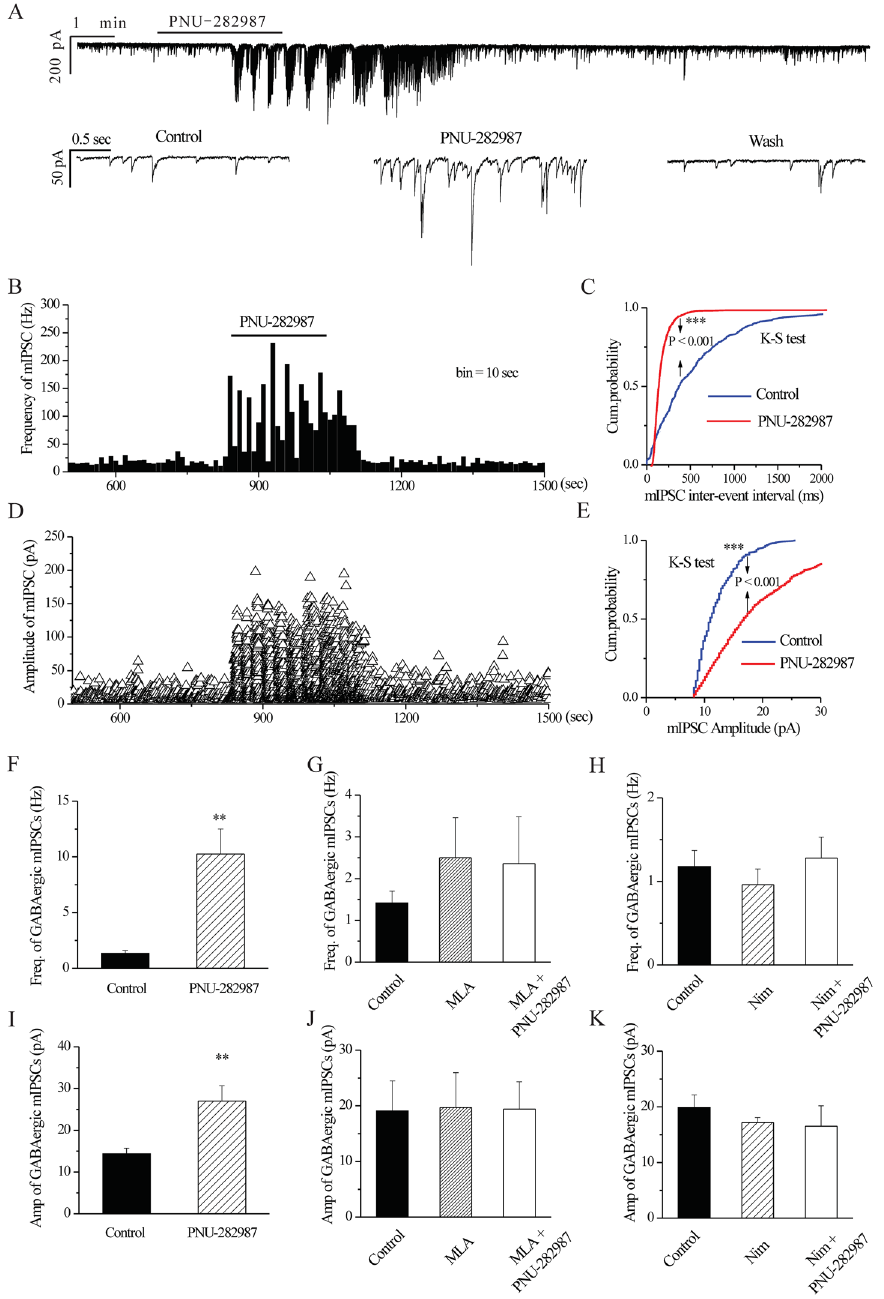
Figure 8. The effects of PNU-282987 on the frequency and amplitude of mIPSCs in glaucomatous RGCs are prevented by MLA or nimodipine. ( A ) Continuous trace of a representative experiment showing mIPSCs at baseline, during PNU-282987 application (10 μ M), and during recovery. The trace is shown at a magnified scale in the lower panel in A. Vertical bar, 200 pA (top) or 50 pA (bottom); horizontal bar, 1 min (top) or 0.5 s (bottom). ( B,D ) Frequency (10 s bin) and amplitude histograms of the mIPSCs of the trace in A , showing the effects of PNU-282987. ( C,E ) Cumulative inter-event interval and amplitude distribution of the mIPSCs of a representative neuron during control recording and during PNU-282987 application. PNU-282987 significantly shifts the distribution of inter-event intervals to the left ( C ) and the distribution of mIPSC amplitudes ( E ) to the right. The PNU-282987 - induced changes in the distribution of inter-event intervals and amplitudes are statistically significant ( n = 6). *** p < 0.001 (Kolmogorov – Smirnov test). ( F,I ) Quantification of the frequency ( F , n = 11) and amplitude ( I , n = 10) of the mIPSCs. ( G,H,J,K ) Pretreatment with MLA ( G,J ; 1 μ M) or nimodipine ( H,K ; 10 μ M) prevents the effects of PNU-282987 on the frequency and amplitude of mIPSCs ( n = 3). Pretreatment with MLA ( G,J ) or nimodipine ( H,K ) does not affect the baseline frequency or amplitude of the mIPSCs. ** p < 0.01 vs. control (Student’s paired t test). The results in F–K are expressed as the mean ±